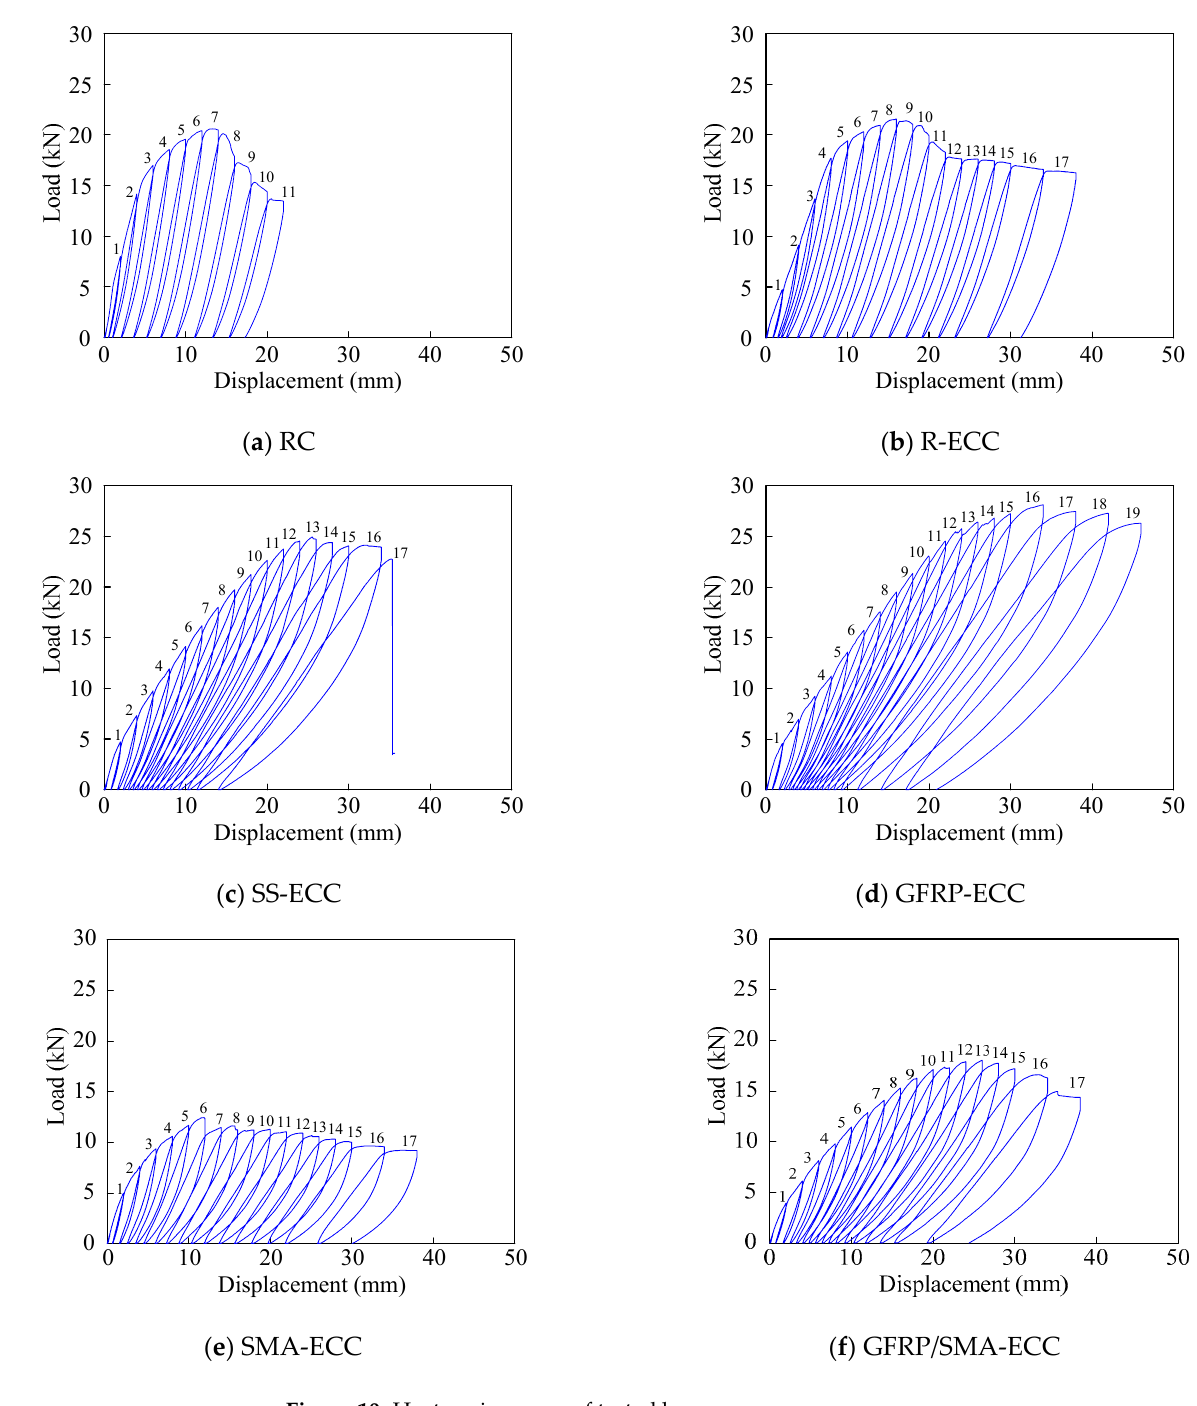
Figure 10. Hysteresis curves of tested beams.